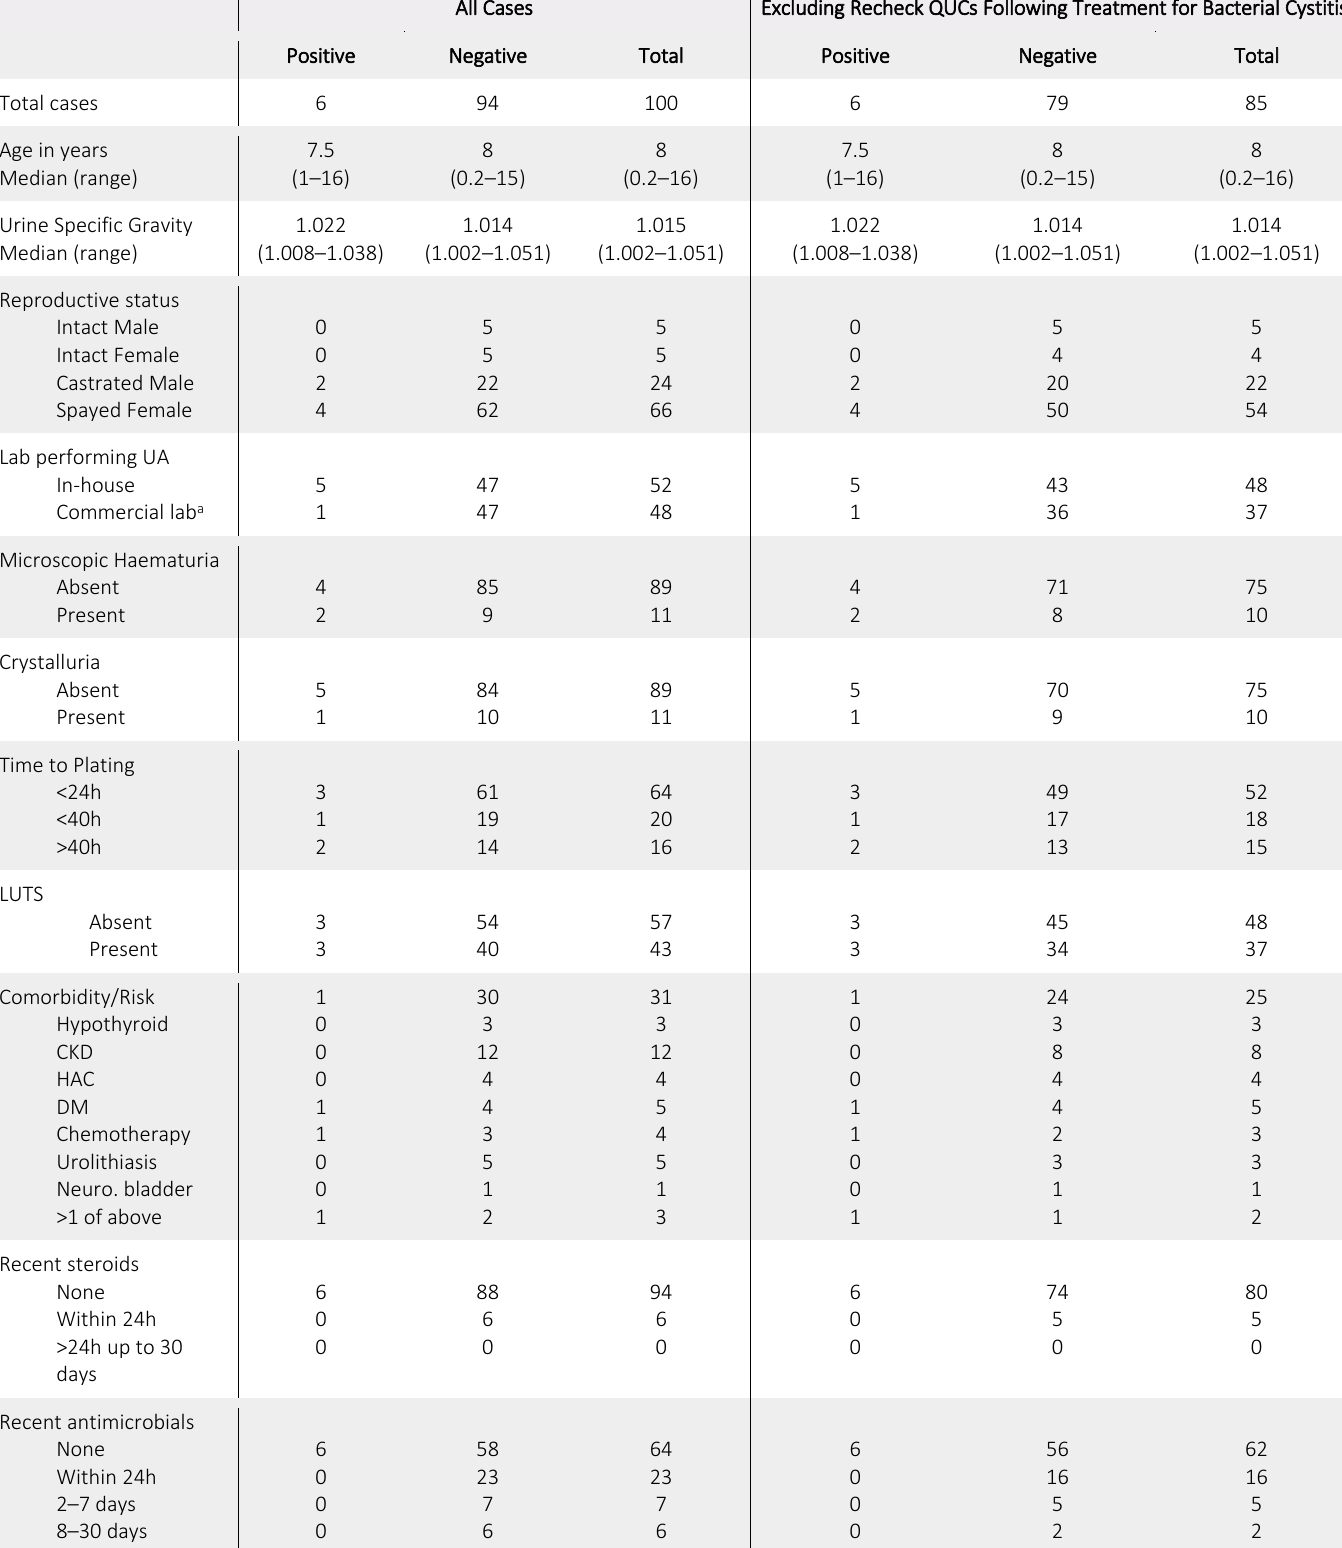
Table 1: Summary of the number of patients with inactive urine sediments in various categories. QUC = quantitative urine